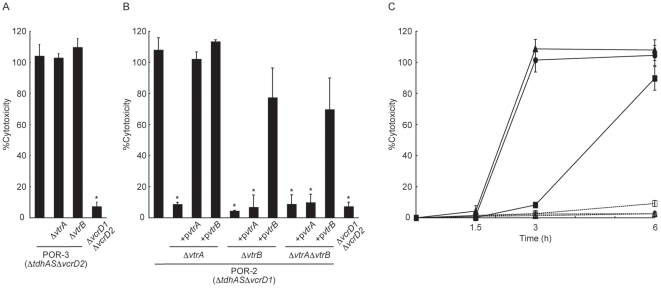
VtrA and VtrB are not necessary for T3SS1-dependent cytotoxicity but necessary for T3SS2-dependent cytotoxicity.A. vtrA and vtrB are not necessary for T3SS1-dependent cytotoxicity. Caco-2 cells were infected for 6 h with isogenic strains of POR-3 (ΔtdhASΔvcrD2). Bar 1: POR-3 (ΔtdhASΔvcrD2); bar 2: POR-3ΔvtrA; bar 3: POR-3ΔvtrB; bar 4: ΔvcrD1ΔvcrD2 (ΔtdhASΔvcrD1ΔvcrD2). Cytotoxicity was evaluated by the amount of LDH released. Error bars represent standard deviations for results from triplicate experiments. B. vtrA and vtrB are essential for T3SS2-dependent cytotoxicity. Caco-2 cells were infected for 6 h with isogenic mutant strains of POR-2 (ΔtdhASΔvcrD1). Bar 1: POR-2 (ΔtdhASΔvcrD1); bar 2: POR-2ΔvtrA (ΔtdhASΔvcrD1ΔvtrA); bar 3: POR-2ΔvtrA expressing vtrA (POR-2ΔvtrA+pvtrA); bar 4: POR-2ΔvtrA expressing vtrB (POR-2ΔvtrA+pvtrB); bar 5: POR-2ΔvtrB (ΔtdhASΔvcrD1ΔvtrB); bar 6; POR-2ΔvtrB expressing vtrA (POR-2ΔvtrB+pvtrA); bar 7: POR-2ΔvtrB expressing vtrB (POR-2ΔvtrB+pvtrB); bar 8: POR-2ΔvtrAΔvtrB (ΔtdhASΔvcrD1ΔvtrAΔvtrB); bar 9: POR-2ΔvtrAΔvtrB expressing vtrA (POR-2ΔvtrAΔvtrB+pvtrA); bar 10: POR-2ΔvtrAΔvtrB expressing vtrB (POR-2ΔvtrAΔvtrB+pvtrB); bar 11: ΔvcrD1ΔvcrD2 (ΔtdhASΔvcrD1ΔvcrD2). Cytotoxicity was evaluated by the amount of LDH released. Error bars represent standard deviations for results from triplicate experiments. Asterisks indicate significant differences from the results obtained with the parent strain (*P<0.05). C. Overexpressing of vtrA and vtrB promoted T3SS2-dependent cytotoxicity. Caco-2 cells were infected for 1.5–6 h with V. parahaemolyticus. Cytotoxicity was evaluated by the amount of LDH released. POR-2 (ΔtdhASΔvcrD1) with control vector (pSA19CP-MCS) (filled squares, solid line), POR-2 expressing vtrA (filled circles, solid line), POR-2 expressing vtrB (filled triangles, solid line), ΔvcrD1ΔvcrD2 (ΔtdhASΔvcrD1ΔvcrD2) with control vector (pSA19CP-MCS) (open squares, dashed line), ΔvcrD1ΔvcrD2 expressing vtrA (open circles, dashed line), and ΔvcrD1ΔvcrD2 expressing vtrB (open triangles, dashed line). Error bars represent standard deviations for results from triplicate experiments. Asterisks indicate significant differences from the results obtained with the parent strain (*P<0.05).